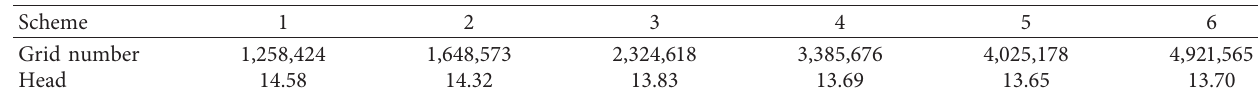
Figure 1: 3D model and hydraulic model of centrifugal pump: (a) 3D model of centrifugal pump; (b) hydraulic model of centrifugal pump. Table 1: Predicted head with various grids.